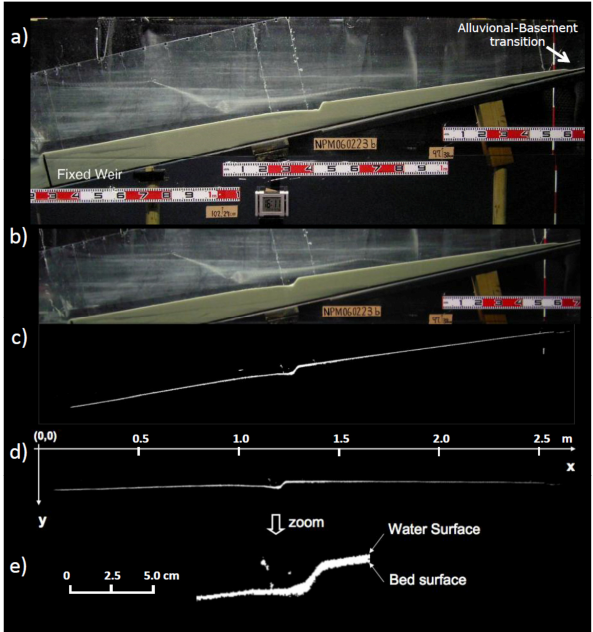
Figure 1. (a) Experimental setup showing the flume, the deposit and the weir; (b) cropped image used for data imaging elaboration; (c) digital image obtained by applying the color threshold to the original image, showing the contrast between white and black that allowed extraction of water depth; (d) the same image, rotated to be parallel to the top set before weir removal; (e) magnified image of the knickpoint area; some extraneous spots are present due to reflections from the glass of the flume